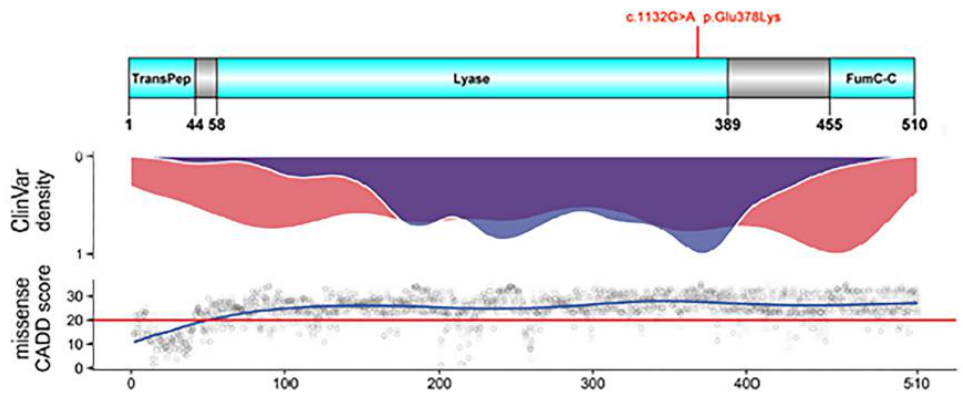
Figure 5. Mutation variant properties. Upper panel: Schematic representation of the FH protein, domains (ticks below x -axis numbered after NP_000134.2 and P07954), and localization of mutation E378K. TransPep, mitochondrion transit peptide; Lyase, N-terminal fumarate lyase domain. Lower panel: Density plot showing the distribution of (likely) pathogenic truncating (red) and missense (blue) variants reported in the publicly available database ClinVar which collects user submitted curations for variant pathogenicity.